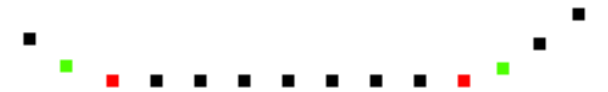
Figure 27. The boundary points used for channel bed restoration.